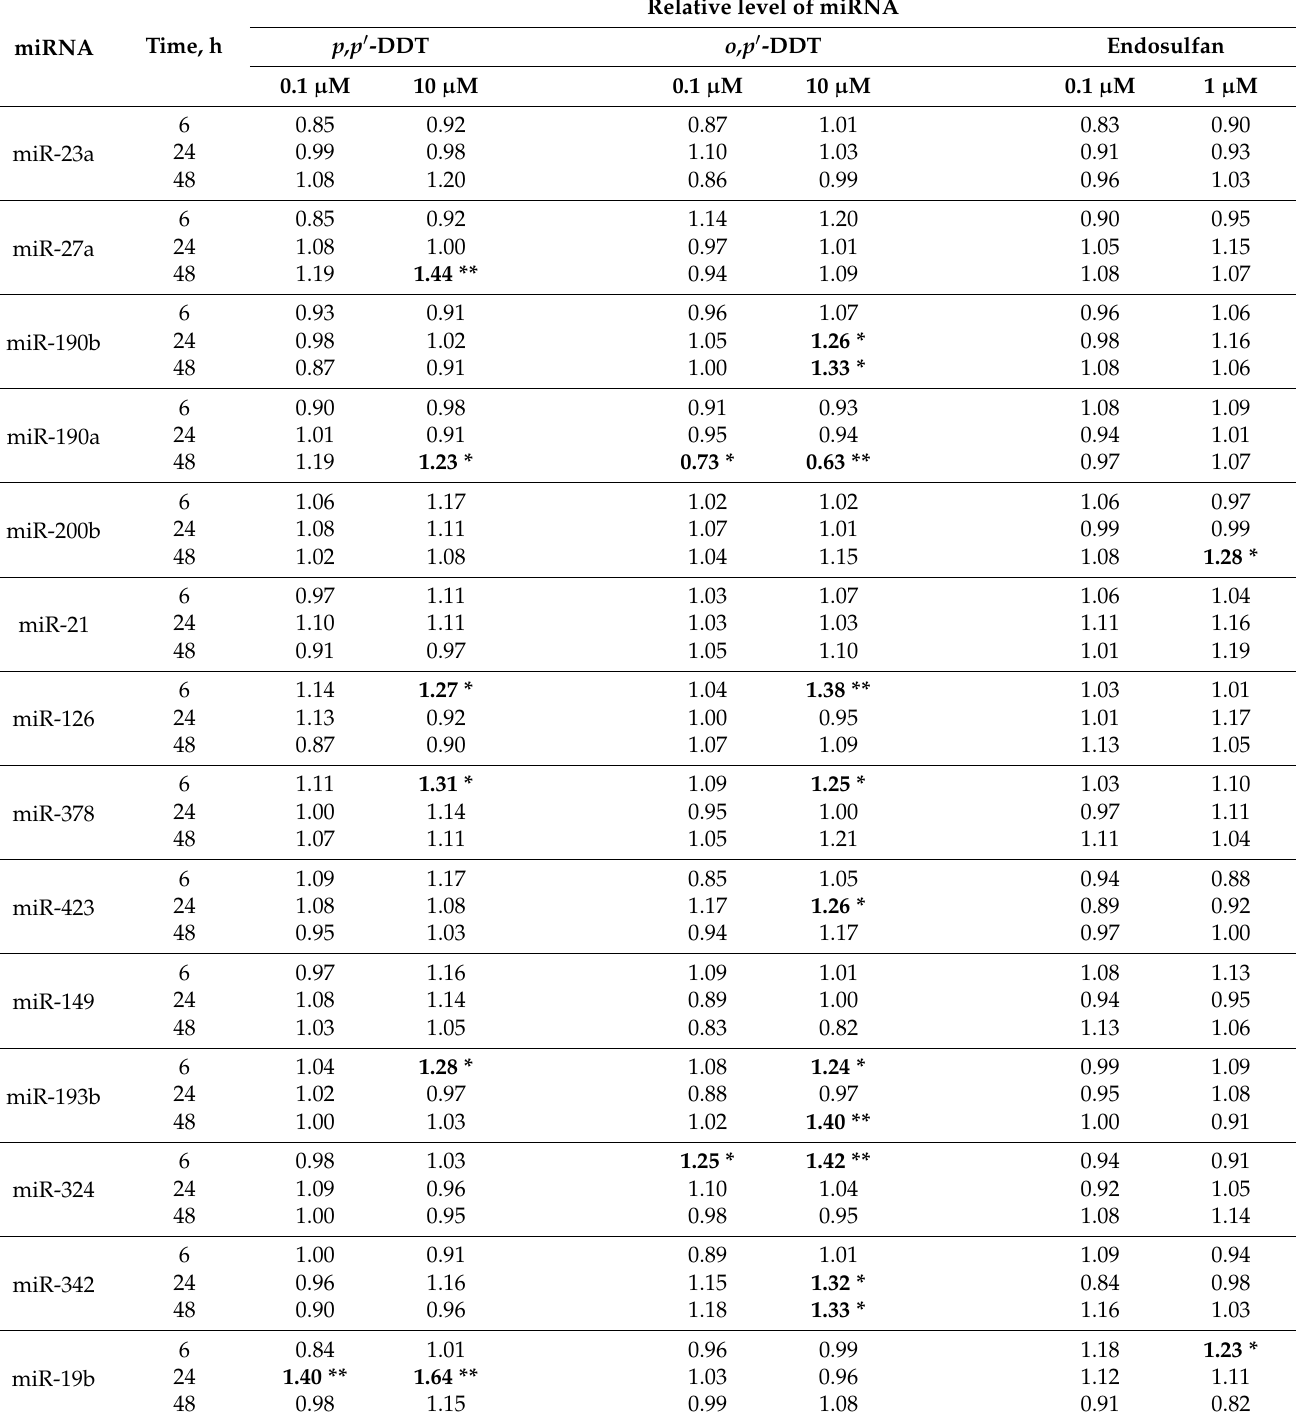
Table 7. Relative miRNA levels in MCF-7 cells treated with p,p (cid:48) -DDT, o,p (cid:48) -DDT, or